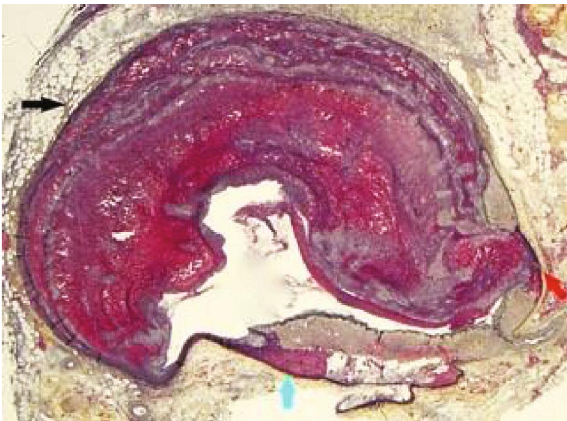
Figure 22: Segmental arterial mediolysis reparative phase. The black arrow points to a gap aneurysm containing a recent thrombus, and the blue arrow to a dissection beginning at the interface of the gap and the arterial wall and developing between the outer media and the fi brin-coated adventitia. Movat stain × 50 (adapted with permission from Modern Pathology 18(3), copyright 1995, Nature Publishing Group).